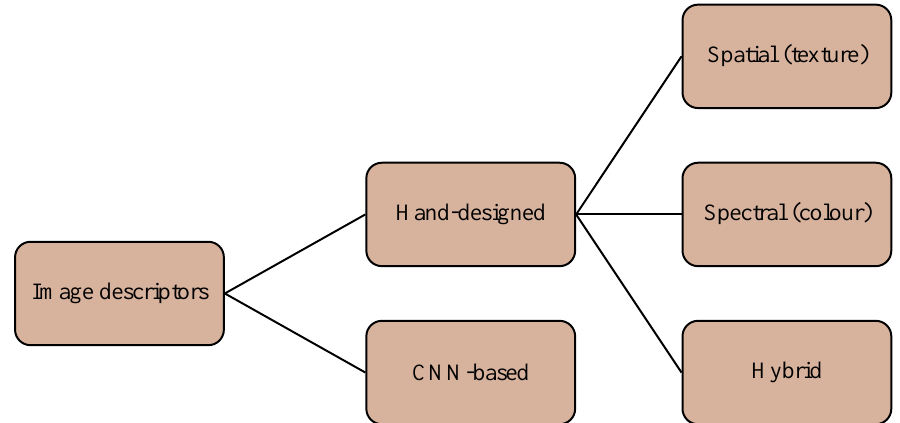
Figure 5. Taxonomy of the image descriptors used in this